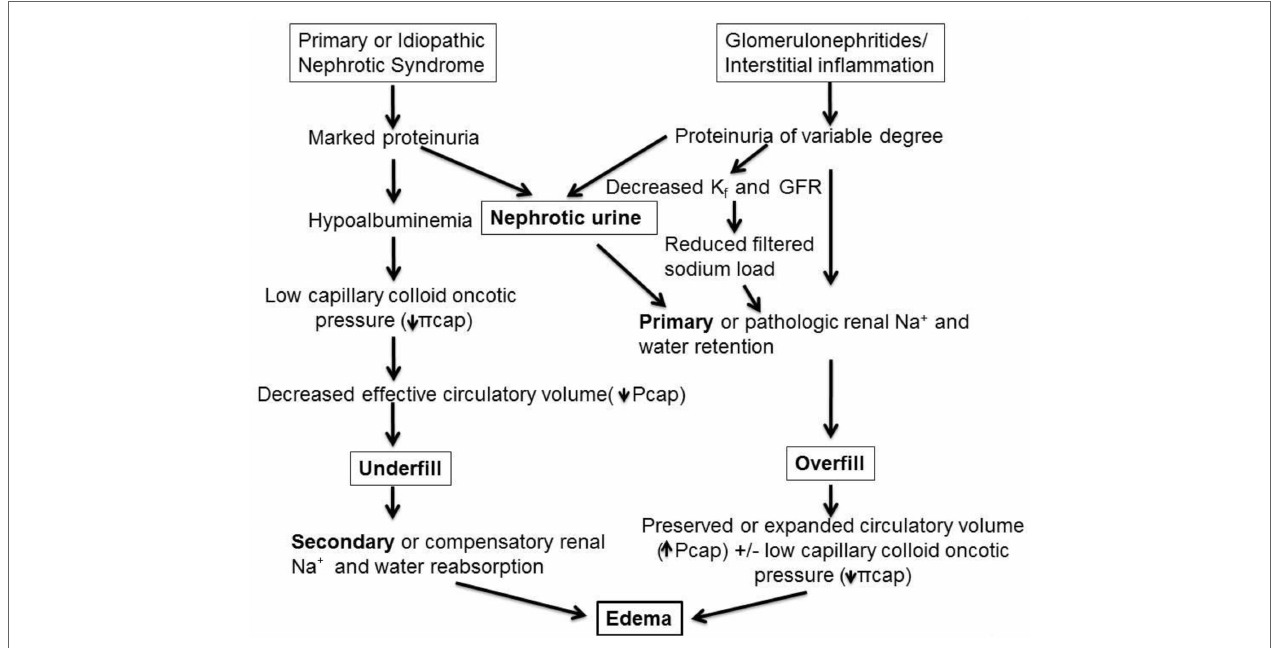
FiGURe 1 | Pathophysiology of edema formation in NS . In disorders with massive proteinuria and marked hypoalbuminemia but minimal or absent renal inflammatory infiltrate, as in most children with minimal-change disease (MCD), the reduction in capillary colloid oncotic pressure ( π cap) favors net fluid exit from the vascular to the interstitial fluid compartment thereby reducing effective circulatory blood volume, denoted as “underfill.” This then triggers secondary, or compensatory, Na + retention and hemodynamic alterations aimed at achieving blood pressure homeostasis. By contrast, various glomerulonephritides and inflammatory renal disorders, such as acute post-streptococcal glomerulonephritis, may be associated with variable degrees of proteinuria and with pathologic release of mediators, which promote primary renal Na + and water retention, as well as vasoconstrictive hormones that are released despite an intact or even expanded intravascular volume. These factors together with reduction in glomerular ultrafiltration coefficient (K f , or LpS in the Starling equation), lead to reduced glomerular filtration rate (GFR) and combine to further limit Na + excretion, resulting in an “overfill” state and rise in capillary hydraulic pressure (Pcap). In turn, this causes net fluid accumulation in the interstitial fluid compartment. Note that nephrotic urine may be a common pathway for primary Na + retention in both undefill and overfill disorders (refer to text and Tables 1 – 3 for the mediators sub-serving each of these main mechanisms of edema